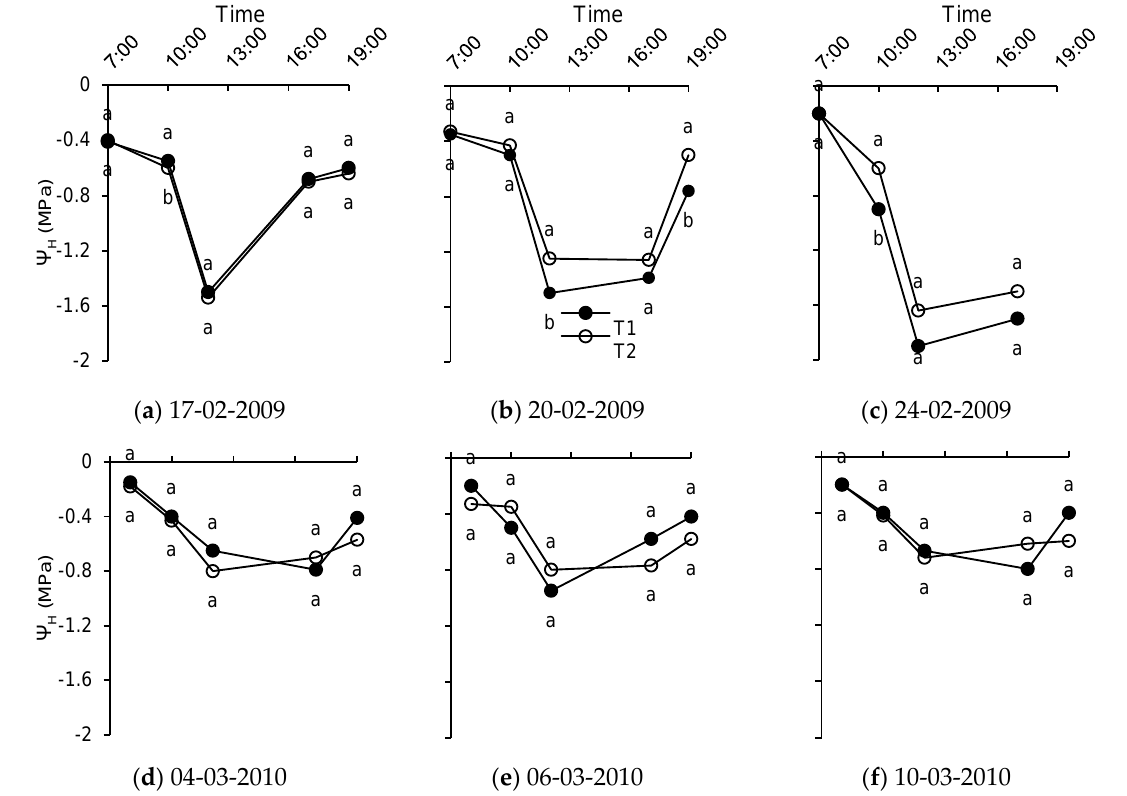
Figure 10. Hourly evolution of leaf water potential ( Ψ H ) in ‘Brookfield Gala’ apple trees for 2010 (date: day-month-year). Each point is the average of eight repetitions. Means with the same letter for the same hour indicate that there are no significant differences according to the ANOVA test ( p < 0.05). T1: Irrigation with theoretical volume required by the plant. T2: Irrigation with farm protocol.